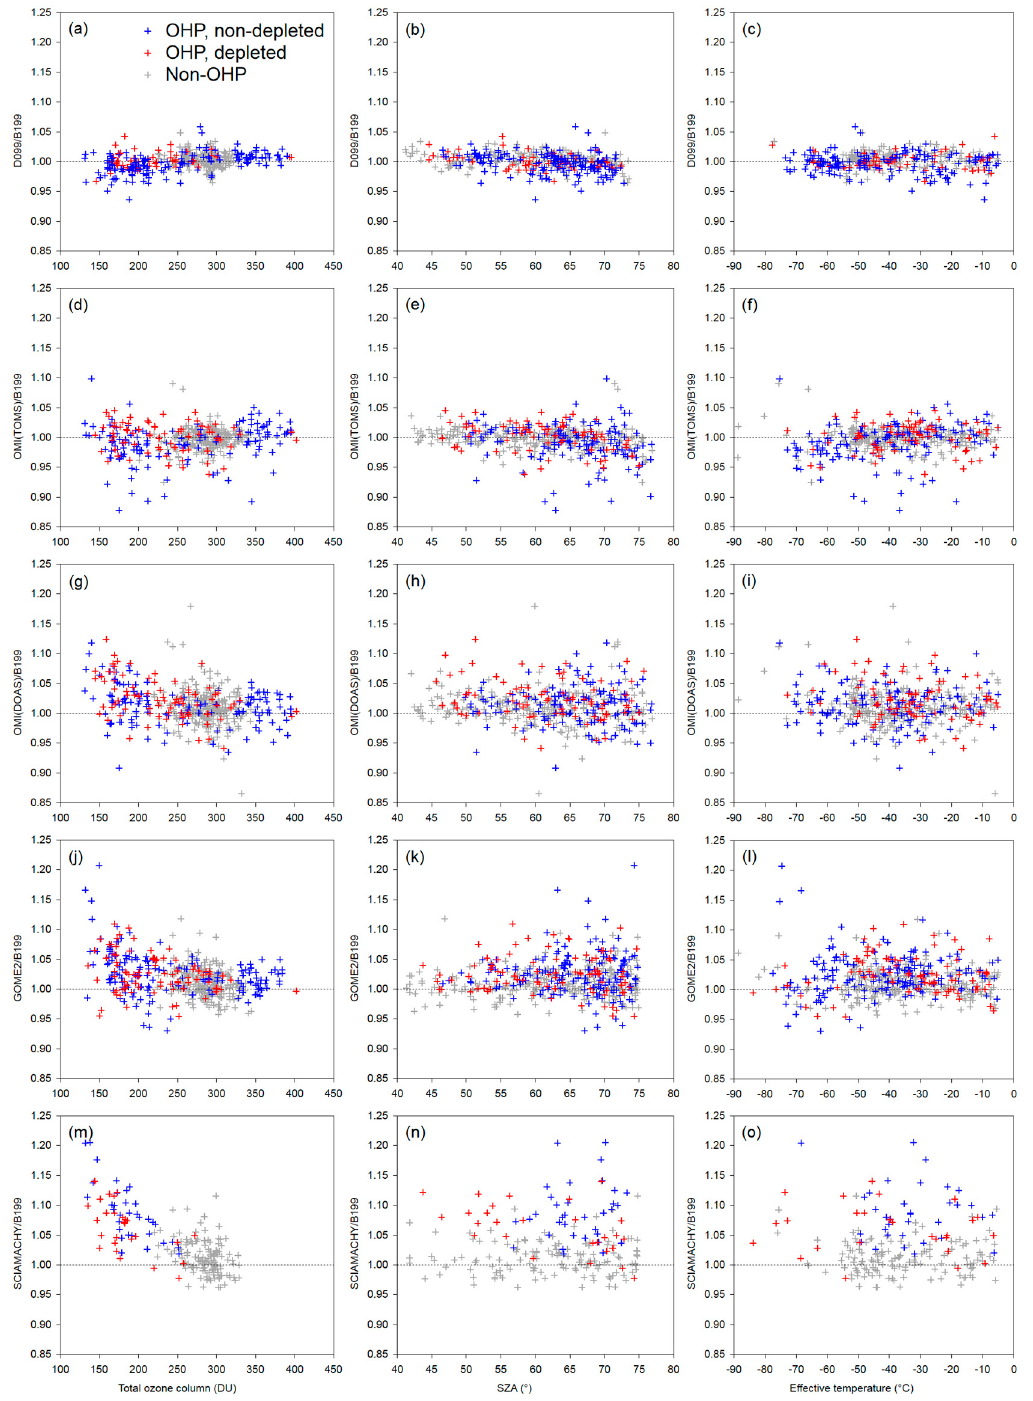
Figure 7. Relationships between the total column ozone measured by the B199 (left), the observation SZA (middle), and T eff measured by the B199 (right), and the ratios in relation to the B199 ozone column for ( a – c ) D099, ( d – f ) OMI(TOMS), ( g – i ) OMI(DOAS), ( j – l ) GOME2, and ( m – o ) SCIAMACHY under non-depleted and depleted ozone conditions at the Marambio Base for the period 2011–2013. OHP stands for the ozone hole period.